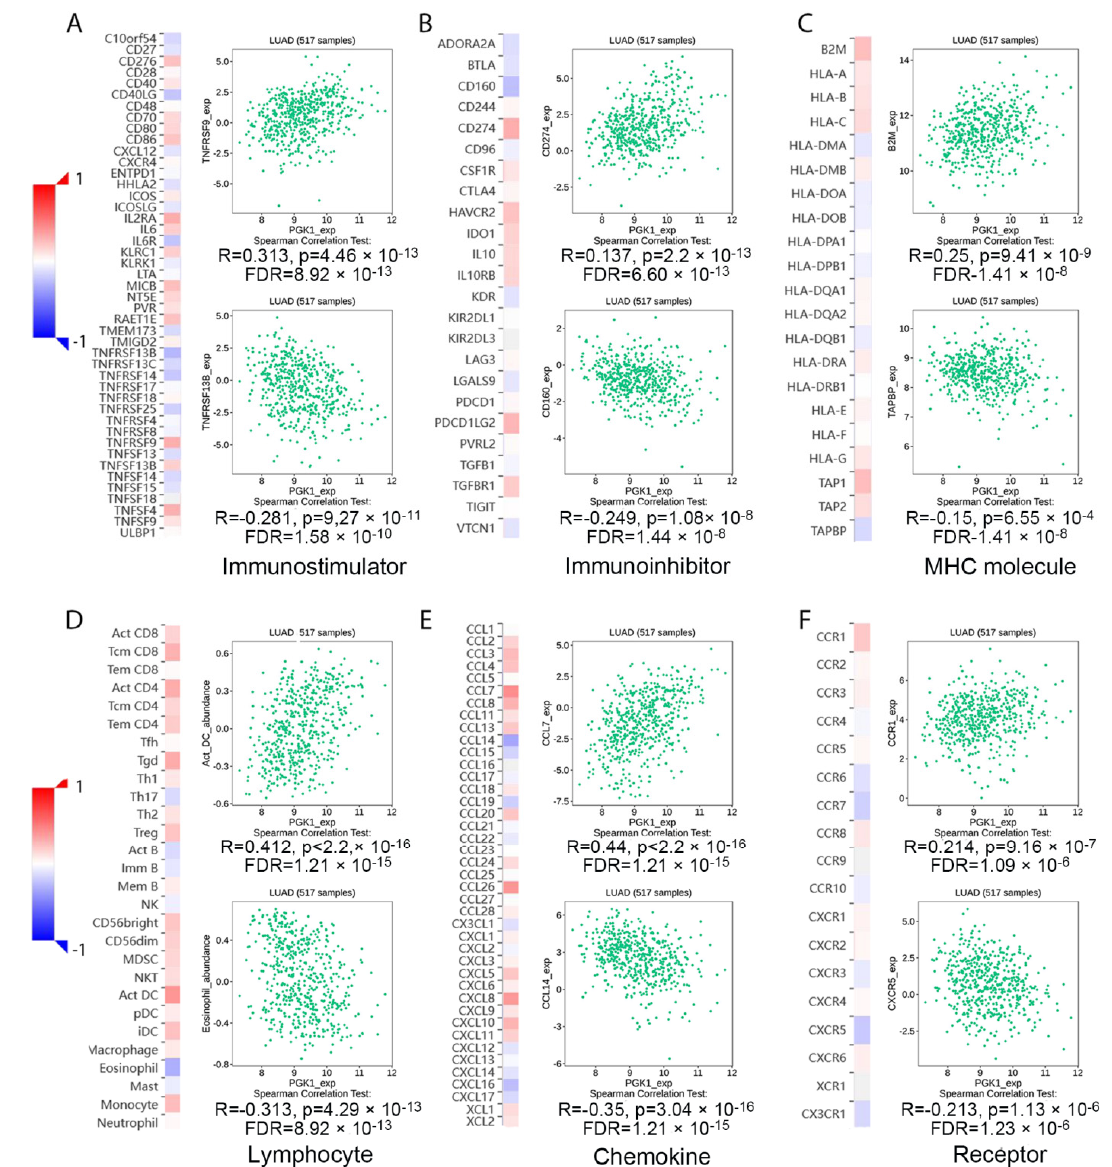
Figure 5. Transcriptional level expression correlation between PGK1 and immunomodula- tors, chemokines, and lymphocytes. ( A ) Relationship between PGK1 and immunostimulators. ( B ) Relationship between PGK1 and immunoinhibitors. ( C ) Relationship between PGK1 and MHC. ( D ) Relationship between PGK1 and Lymphocytes. ( E ) Relationship between PGK1 and chemokines. ( F ) Relationship between PGK1 and receptors.